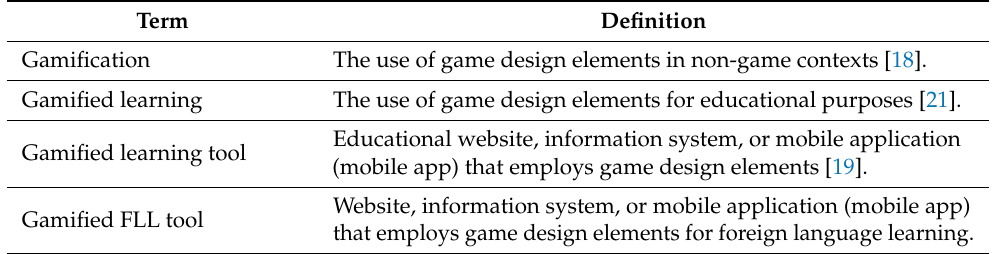
Table 1. Terms and definitions. Term Definition Gamification The use of game design elements in non-game contexts [18]. Gamified learning The use of game design elements for educational purposes [21]. Educational website, information system, or mobile application (mobile app) that employs game design elements [19]. Website, information system, or mobile application (mobile